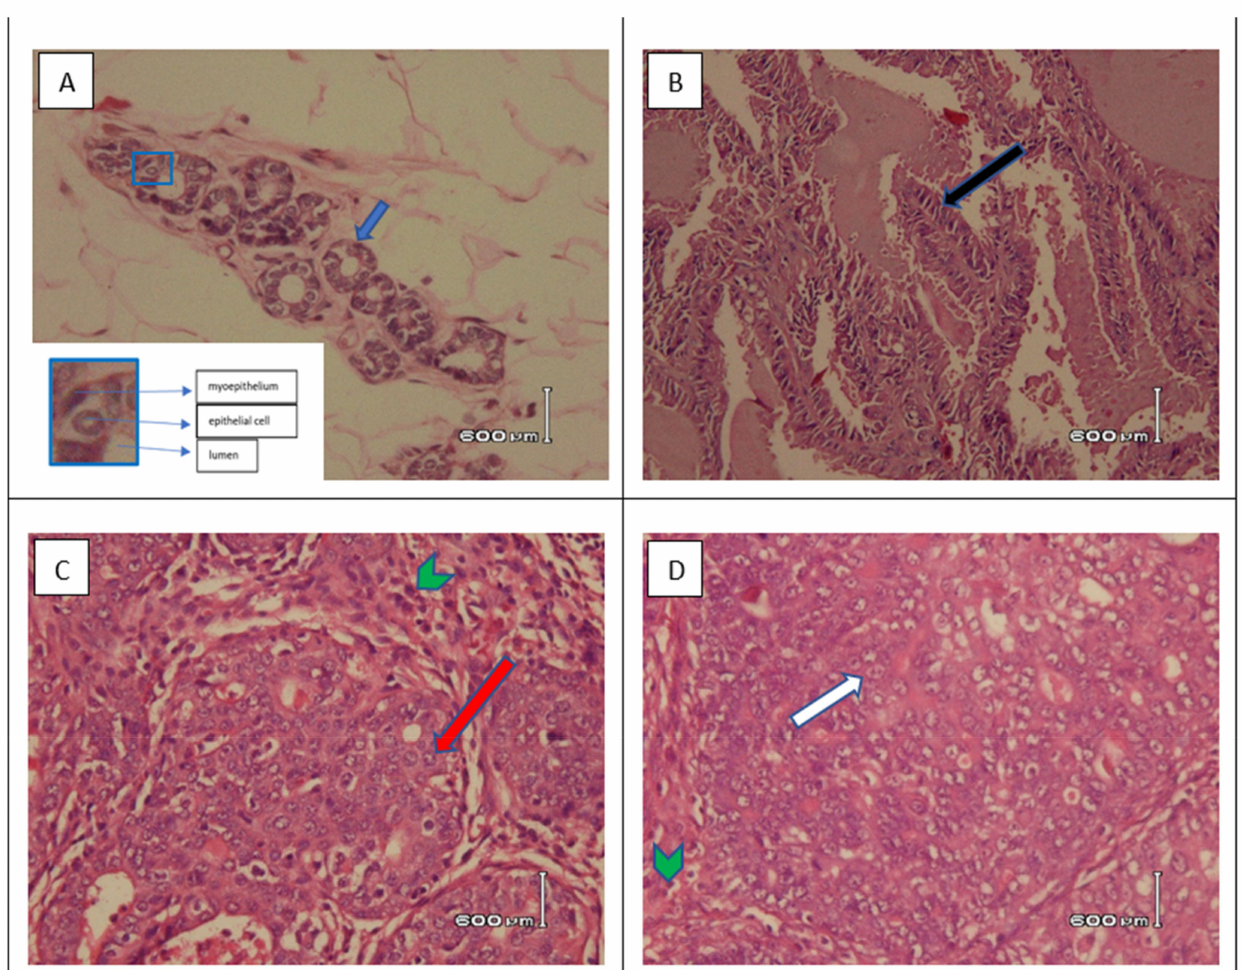
Figure 6. Microscopic view of mammary tissue of SD rats induced by DMBA by giving CXBC for two weeks and five weeks during induction (HE staining). Notes: ( A ) normal tissue (400 × ). Mammary gland ducts are composed of non-atypia epithelial cells and myoepithelium (insert), ( B ) tissue with papillary carcinoma (100 × ). Delicate papillary fronds (black arrow) and expansile papillary tumor, with low or intermediate grade nuclei, cuboidal to columnar epithelial cells that lacks myoepithelial cells along the papillae and at the periphery or shows focal peripheral myoepithelial staining; ( C ) tissue with Ductal carcinoma in situ (400 × ). An intraductal epithelial proliferation with intermediate grade nuclear atypia (red arrow), tubular and cribriform growth pattern with sufficient lymphocyte reaction (green arrow head); ( D ) tissue with invasive ductal carcinoma of no special type (NST) (400 × ). The preparation shows solid and tubular epithelial tumor tissue, infiltrative to the surrounding connective tissue. Tumor cells are atypia, polymorphic, large size. Cytoplasm a little until enough. The nuclei (white arrow) are large, pleomorphic, round, oval, polygonal, irregular chromatin, partly vesicular with nucleolus are clearly visible. Mitosis is slight. Lymphocyte reaction is slight (green arrow